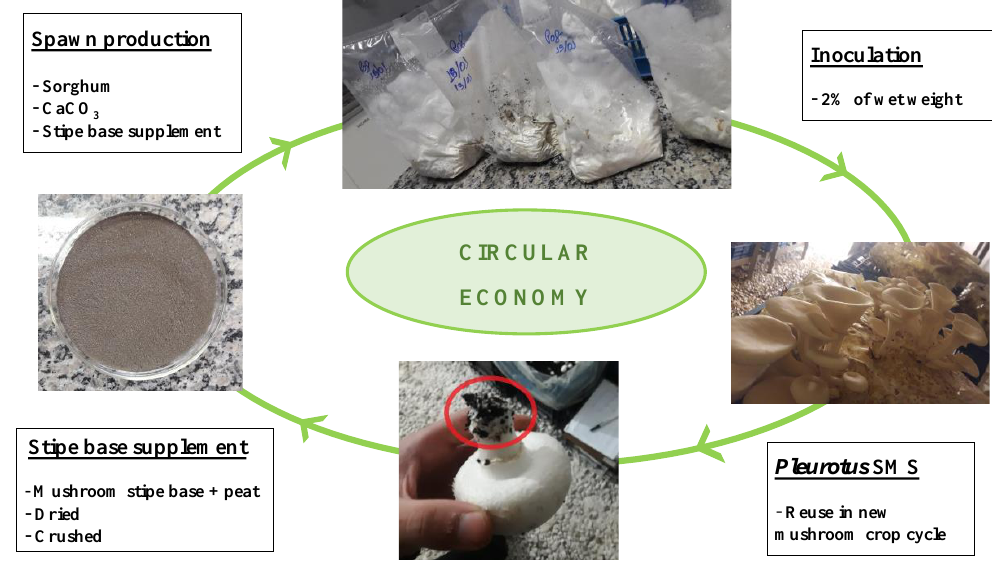
Figure 5. Use of A. bisporus stipe base as a supplement to spawn production in the cultivation of P. ostreatus , a second example of the application of mushroom waste in a circular economy .